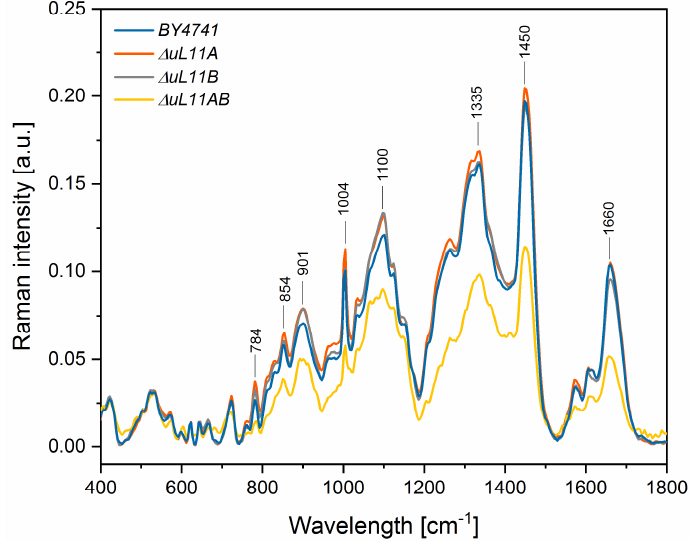
Figure 10. Raman spectra of the yeast cultures with regions corresponding to vibrations of functional groups building RNA, polysaccharides, phospholipids, nucleic acid, carbohydrates, proteins, and